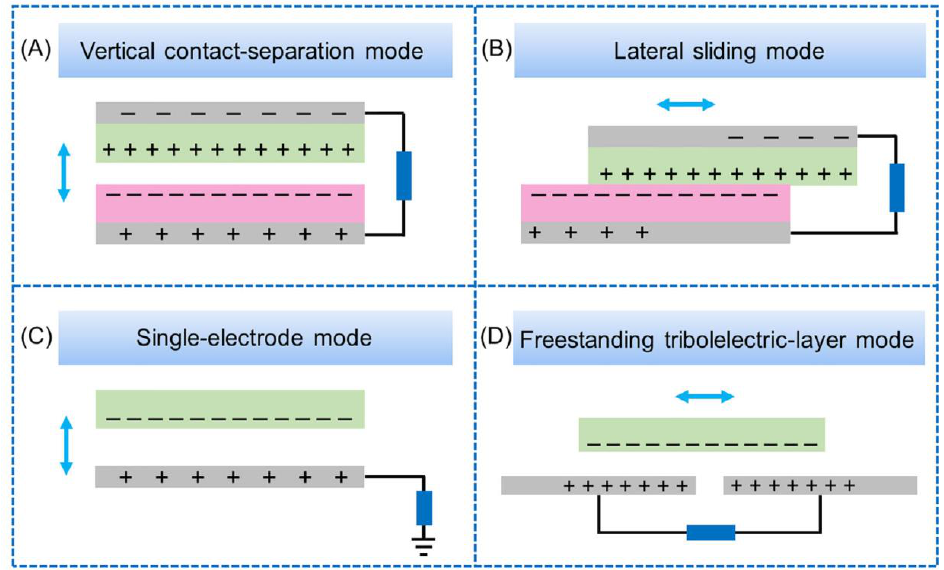
Figure 2. ( a ) Vertical contact-separation mode. ( b ) Lateral sliding mode. ( c ) Single-electrode mode. ( d ) Freestanding triboelectric-layer mode. Reprinted with permission from [39]. 2020, copyright John Wiley and Sons.